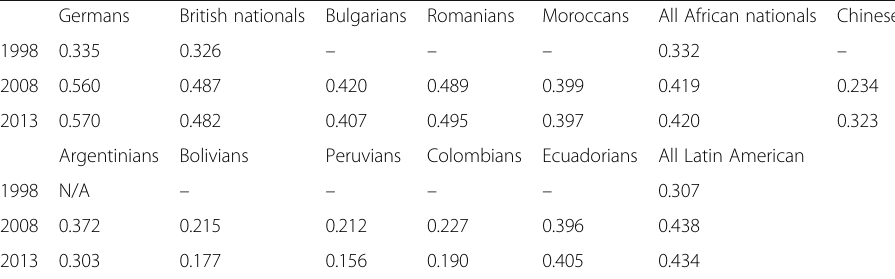
Table 3 Global Moran index for selected nationalities in